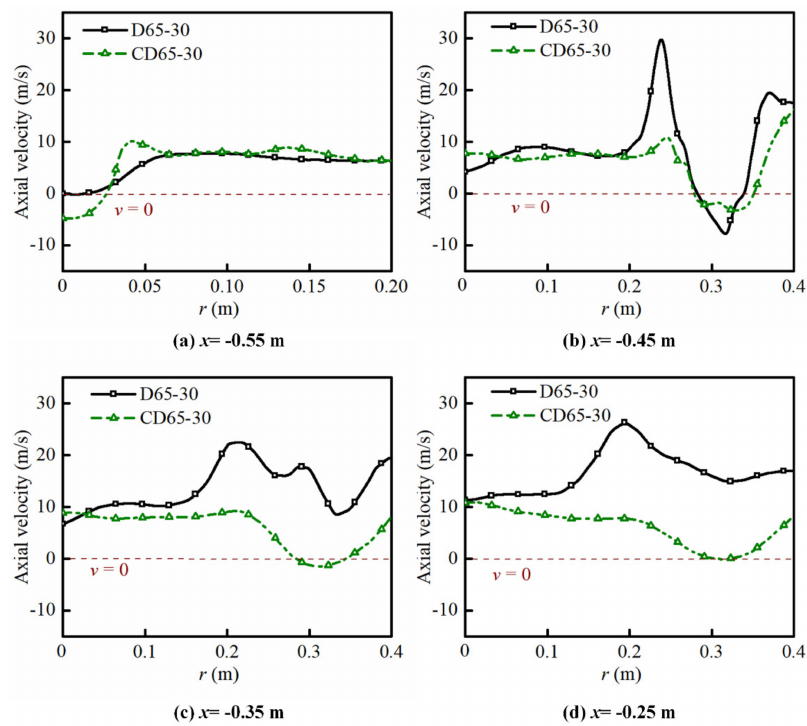
Figure 6. Axial velocity of D65-30 and CD65-30 at different axial positions.